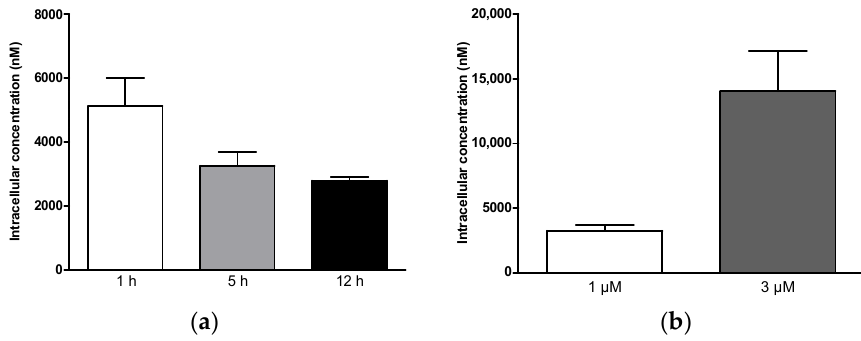
Figure 7. Uptake of 4p in A431 cancer cell line. ( a ) Time-dependent changes in the intracellular concentration of 4p in the presence of 1 µM of extracellular concentration of the compound. Cells were harvested at 1, 5, and 12 h post-treatment, counted, and lysed. ( b ) Concentration-dependent changes in the intracellular concentration of 4p in the presence of 1 or 3 µM of extracellular concentration of the compound. Cells were harvested at 5 h post-treatment, counted, and lysed. In both ( a ) and ( b ), the concentration of 4p in the soluble fraction of the lysate was determined via LC-MS/MS using matrix calibration. Data represent mean ± SD from an experiment with three replicates.